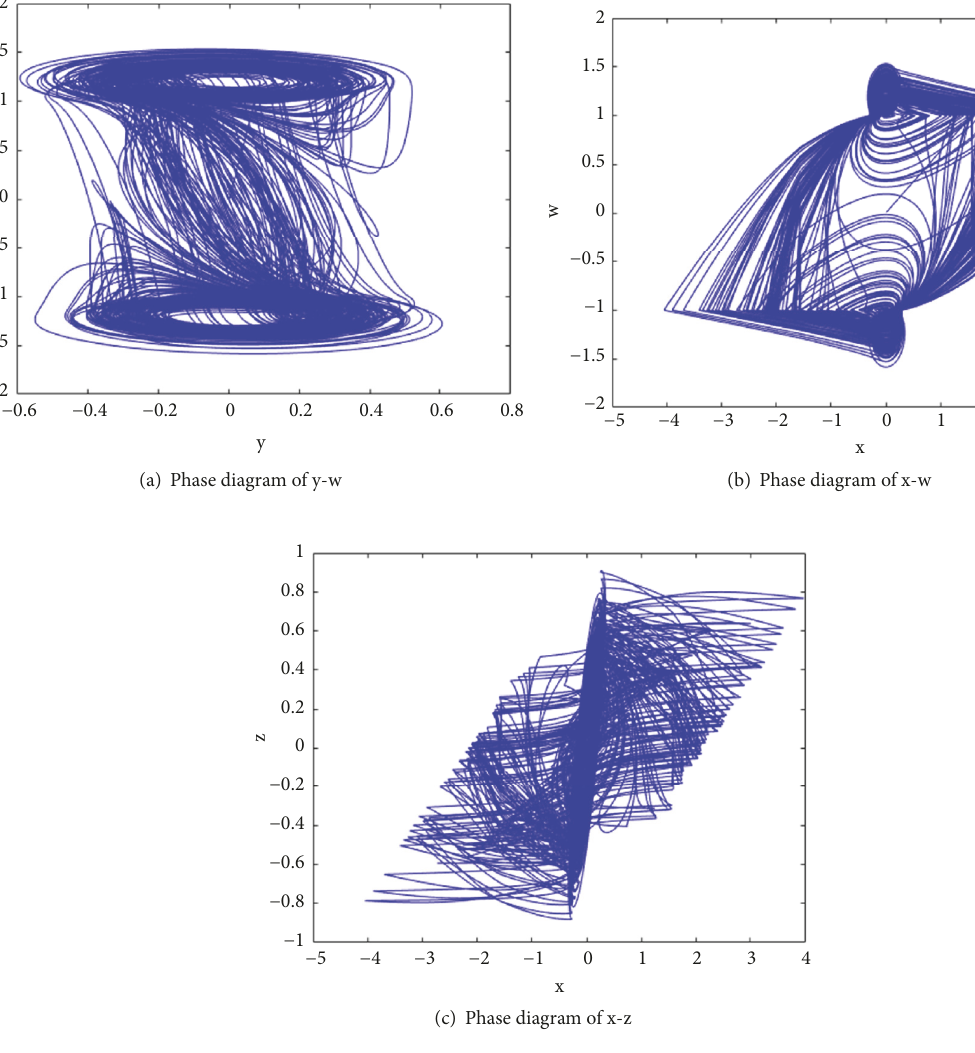
Figure 2: Phase diagram of state variables of the memristor-based